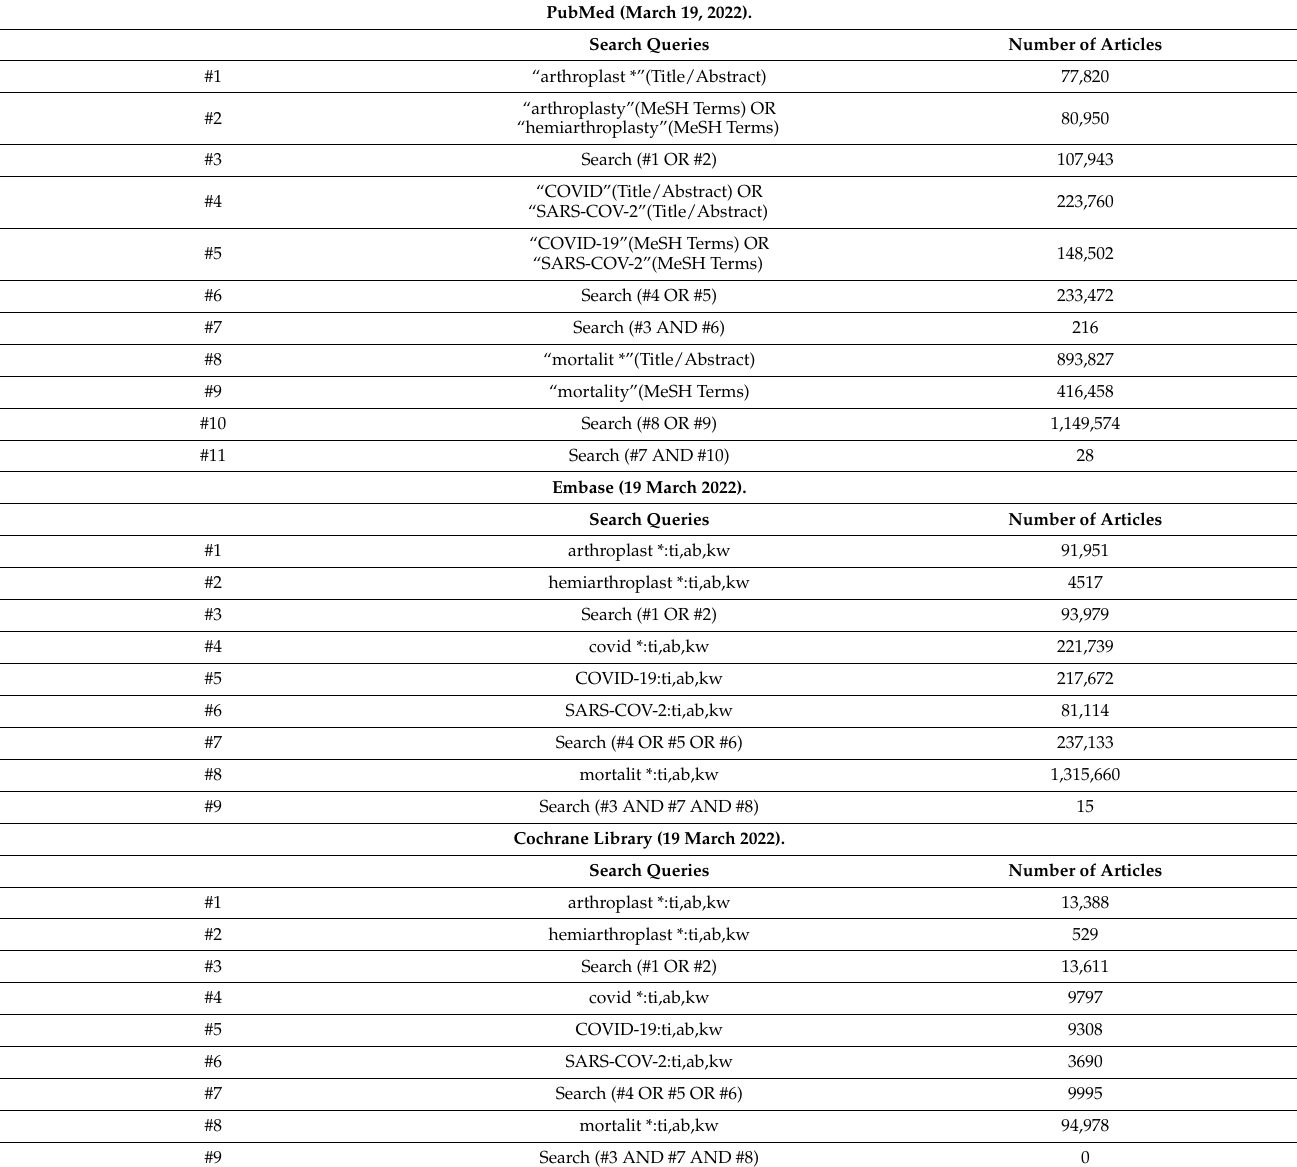
Table A1. Literature search algorithm and results from relevant clinical